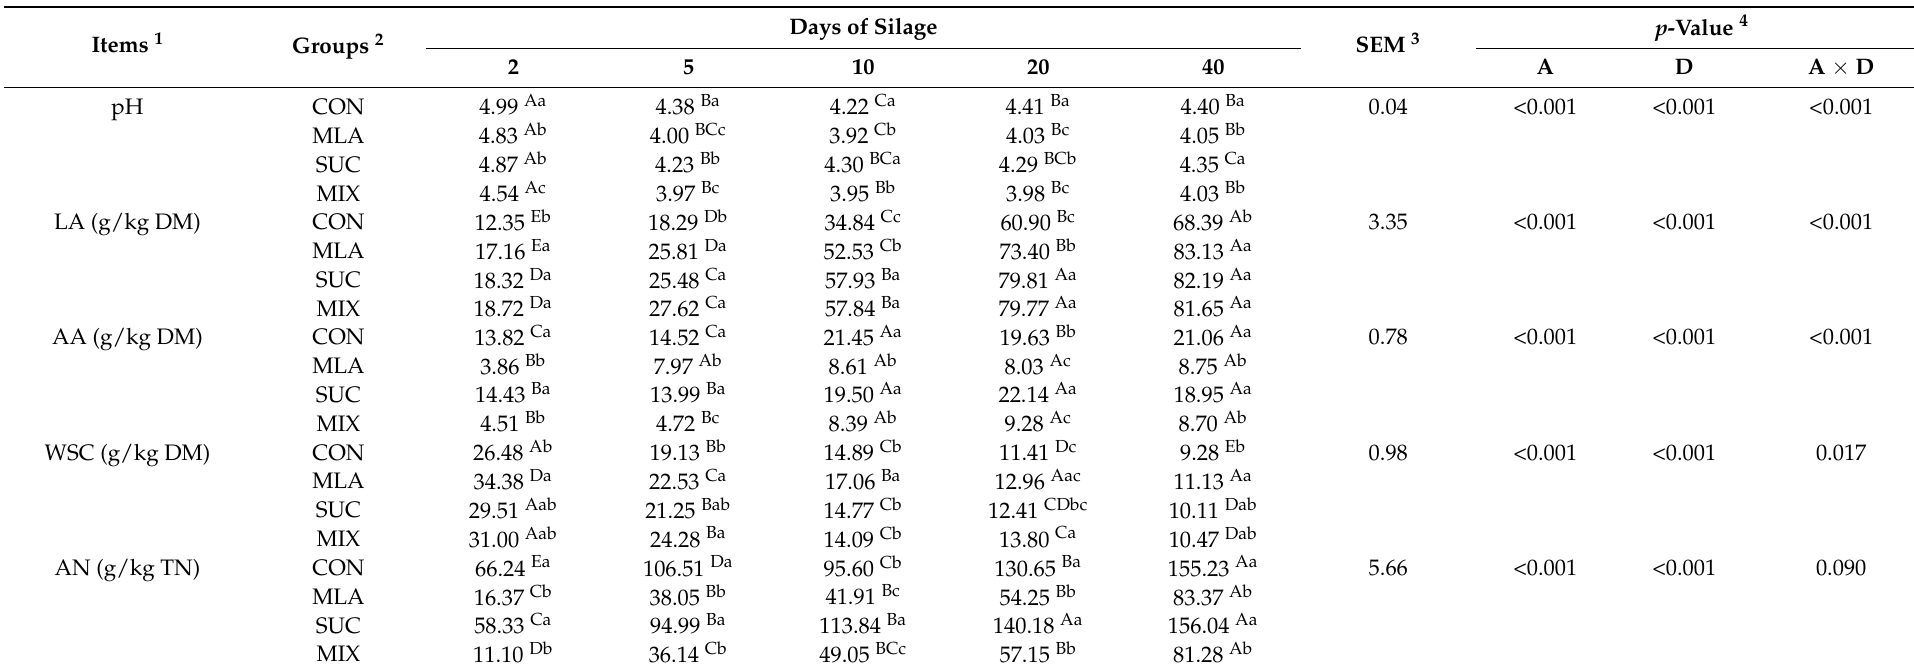
Table 1. Fermentation quality of ensiled Moringa oleifera leaves treated with malic acid and